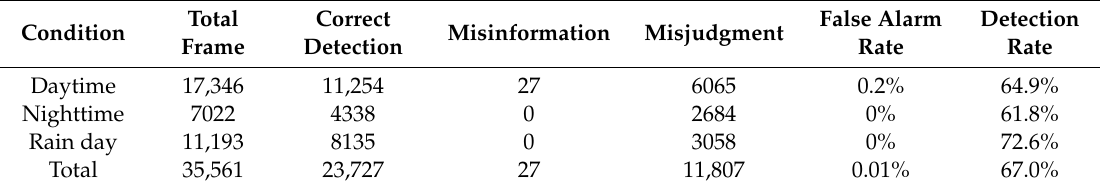
Table 2. Detection results of radar systems under di ff erent weather